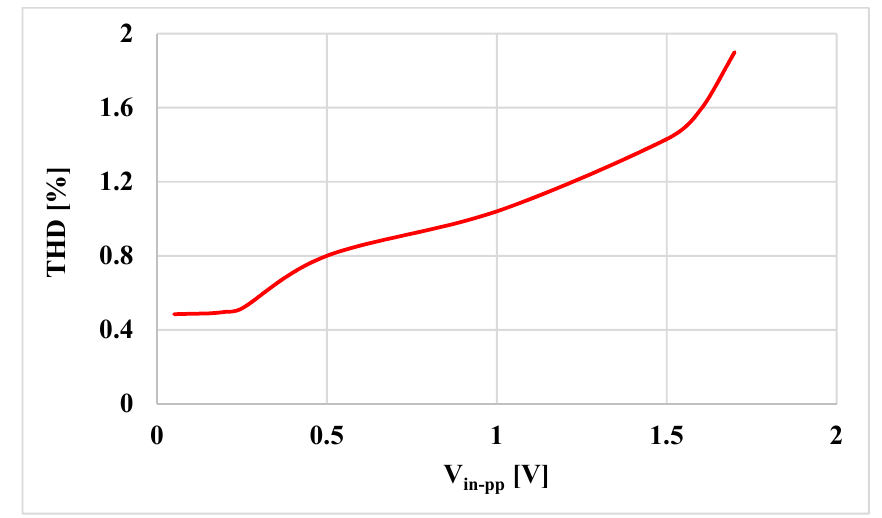
Figure 30. The total harmonic distortion (THD) of the filter versus the V in-pp .